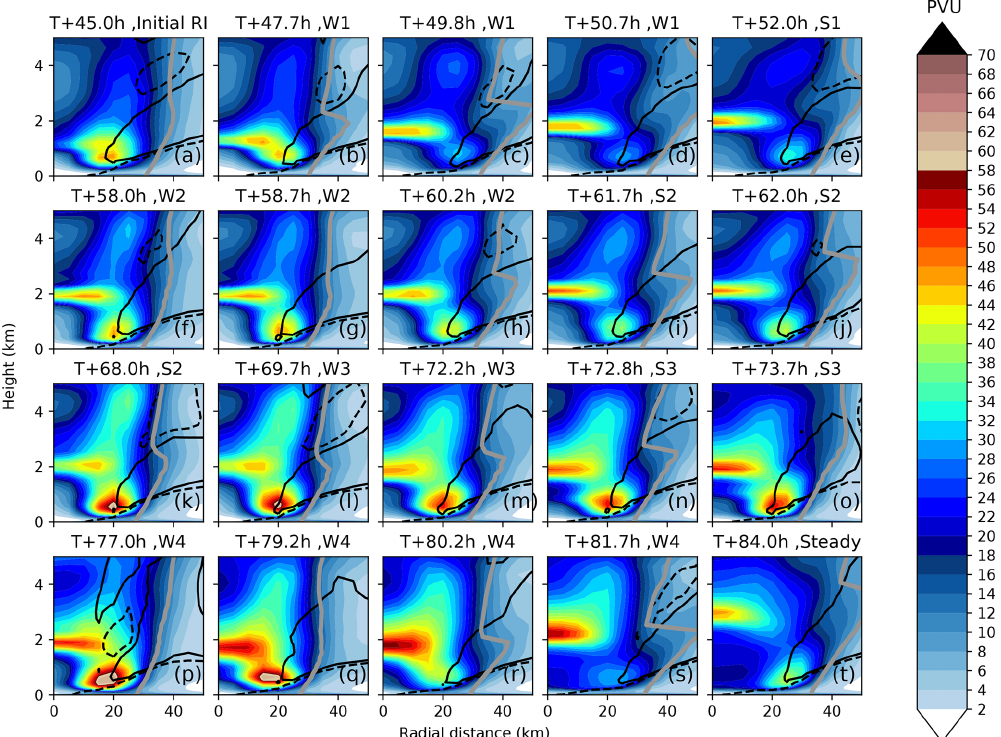
Figure 6. Azimuthally averaged PV (PVU, shaded) as a function of radial distance and height for selected times. The height-dependent RMW is indicated by the grey line. Also shown are the 1ms − 1 (black line) and − 1ms − 1 (dashed black line) radial wind contours.